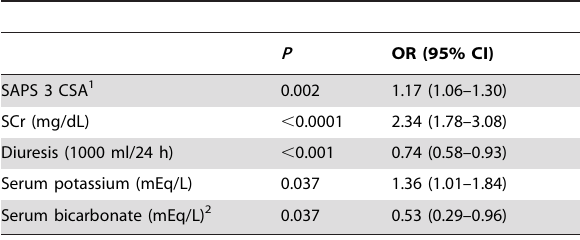
Table 3. Patients’ characteristics comparing delayed and early nephrology consultation (NC) groups on AKI diagnosis day.